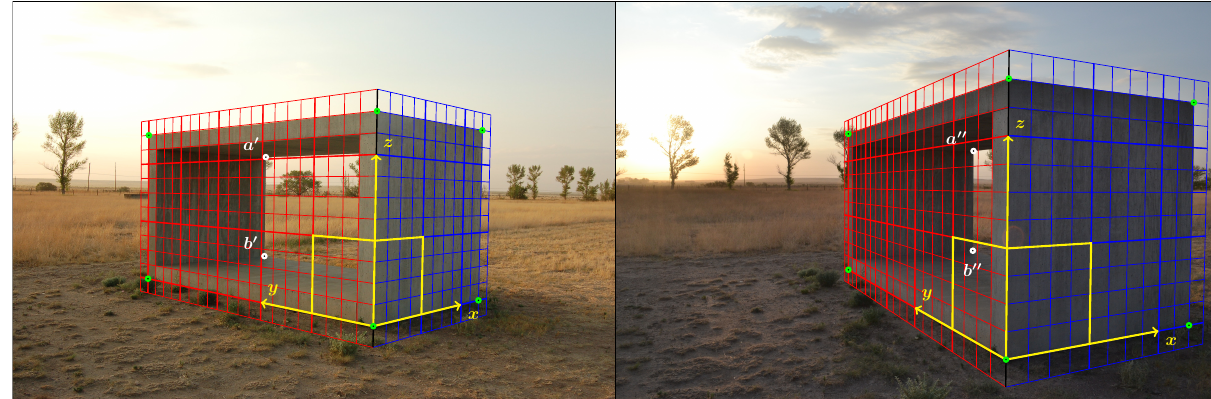
Figure 8. One of Donald Judd’s concrete blocks in Marfa, Texas (Photo by Emanue3, 2011, left) and (Photo by Kbennett0016, 2011, right). The green dots are measured on the outer corners of the 2.5m × 2.5m × 5m concrete block. The blue and red plane are defined by the four corresponding green outer corners of the corresponding sides of the concrete block. The yellow squares show the unit squares on each plane (1m × 1m). The red and blue plane could principally be arbitrarily extended over the whole image plane (in the image they reach about 25cm over the dimensions of the concrete block). The white dots show two more homologue points in the two images. It is easy to see that e.g. a (cid:48) projects on the red plane at y - z -coordinates of about (2 , 2) . However, a (cid:48) also projects on the blue plane at x - z -coordinate of roughly ( − 2 , 2) . The image does not show the extension of the blue plane over the white dots since it would mess up the drawing too